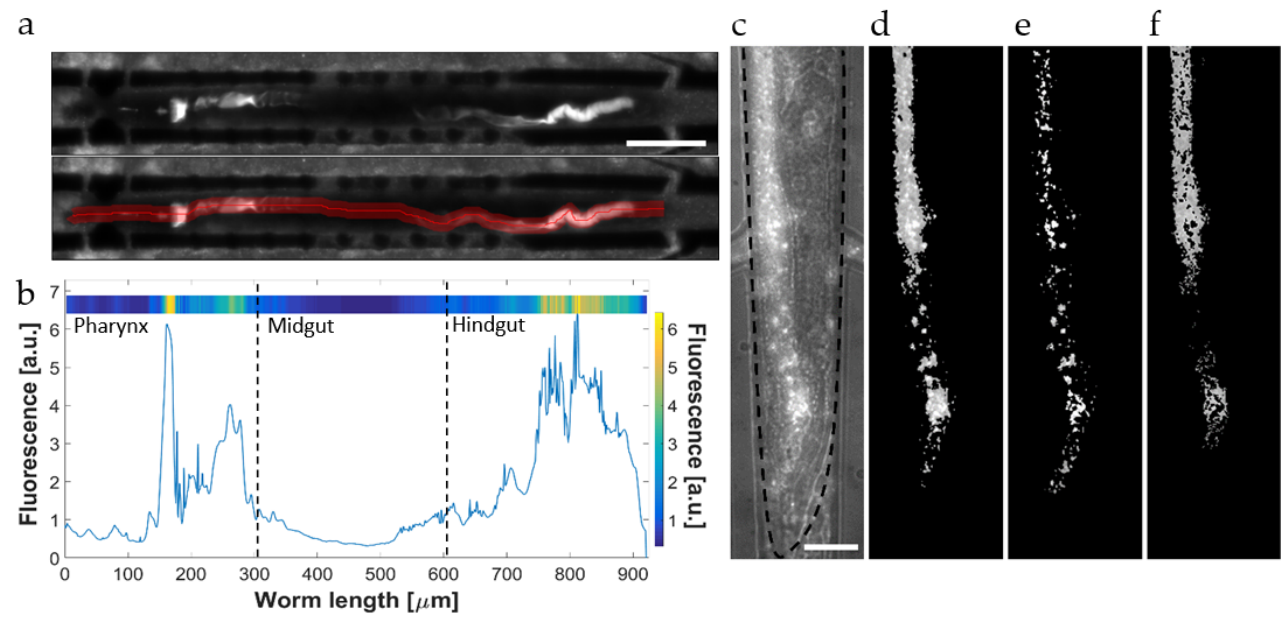
Figure 2. Automated image analysis for fluorescence measurements of the bacterial load in the worm’s gastrointestinal tract. ( a ) Low-magnification (20×) fluorescent image of a trapped adult N2 worm fed E. coli OP50 expressing RFP. The fluorescent signal generated by the bacterial load is mainly visible in the pharyngeal (grinder) and the hindgut regions. The signal was measured along a manually defined line corresponding to the intestinal tract (averaged over a width of 20 μ m, lower image). Scale bar = 100 μ m. ( b ) Fluorescence amplitude measured over the whole worm length from the head ( l = 0 μ m) to the tail region ( l = 920 μ m). For clarity, the intestine was segmented in three parts, indicated as pharynx, midgut, and hindgut. These regions are delimited by dashed lines in the plot. The peak at l = 150 μ m and the broader peak centered at l = 800 μ m correspond to the bright regions in ( a ). A linear color code scheme of the graph was generated (panel in the upper part of Figure 2b). ( c ) High-resolution (50×) brightfield/fluorescence imaging (hindgut of a N2 adult worm, highlighted by the dashed line) reveals diffuse fluorescence in the gut generated by disrupted bacteria and fluorescent spots related to the presence of intact bacteria/bacterial clusters. ( d ) The total fluorescence distribution and ( e ) bright signals related to intact bacteria are discriminated by applying two subsequent thresholding steps. ( f ) The signal associated with diffuse fluorescence is obtained by subtraction of ( e ) from ( d ). Scale bar = 25 μ m.